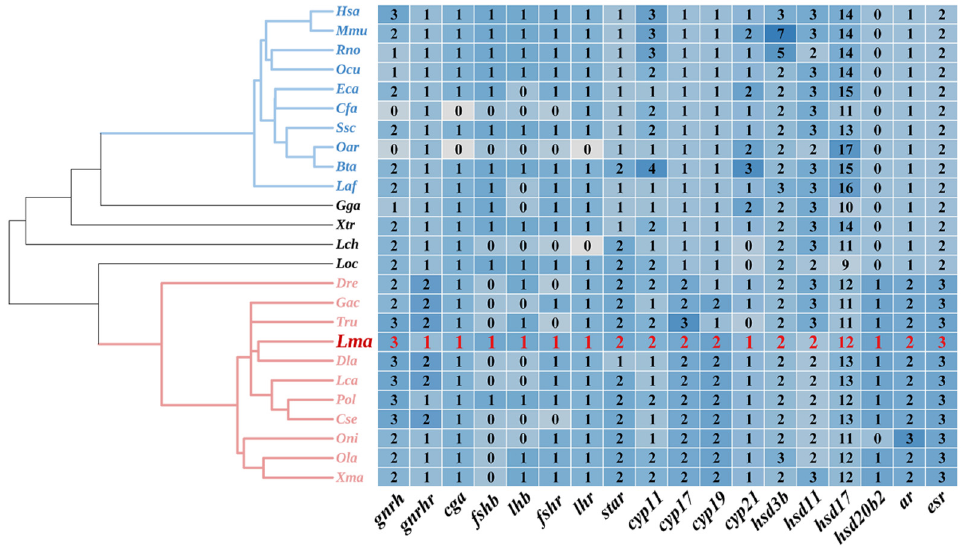
Figure 1. Copy numbers of HPG axis genes in selected vertebrate genomes presented in a heatmap, along with their phylogeny. Copy number comparisons were made among the HPG axis genes in 10 mammals, chicken, frog, spotted gar, coelacanth, and 11 teleosts. In the phylogenetic tree, blue lines represent mammalian lineages and pink lines represent teleost lineages. Abbreviations: human ( Hsa ), monkey ( Mmu ), Norwegian rat ( Rno ), rabbit ( Ocu ), horse ( Eca ), dog ( Cfa ), pig ( Ssc ), sheep ( Oar ), cattle ( Bta ), African savanna elephant ( Laf ), chicken ( Gga ), tropical clawed frog ( Xtr ), coelacanth ( Lch ), spotted gar ( Loc ), zebrafish ( Dre ), stickleback ( Gac ), pufferfish ( Tru ), Chinese sea bass ( Lma ), European sea bass ( Dla ), Asian sea bass ( Lca ), Japanese flounder ( Pol ), Chinese tongue sole ( Cse ), tilapia ( Oni ), Japanese medaka ( Ola ), platyfish ( Xma ).